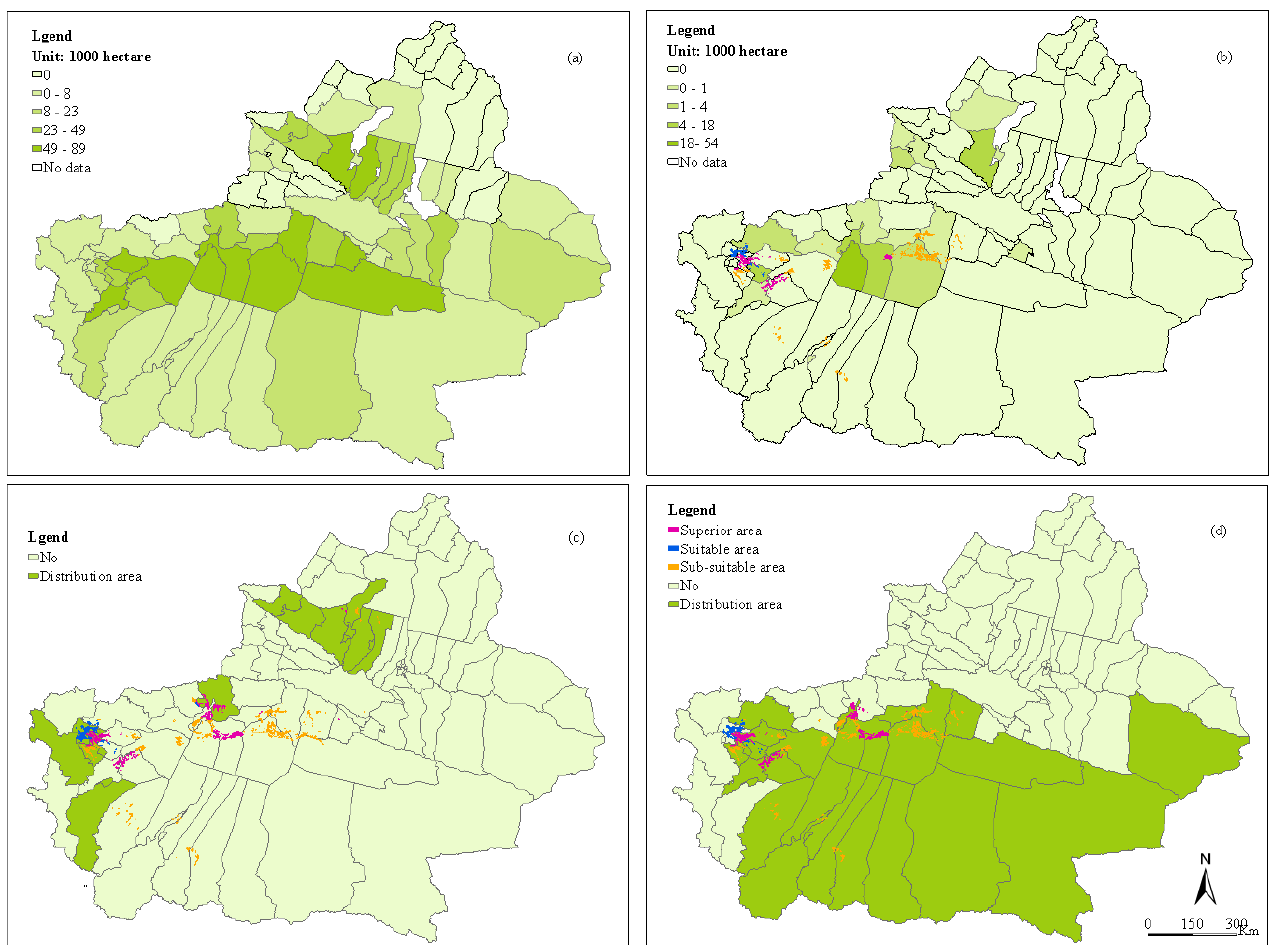
Figure 13. ( a ) Average cotton planting area in Xinjiang from 2008 – 2018; ( b ) Average long staple cotton (LSC) planting area in Xinjiang from 2008 – 2018 and appropriate areas for LSC seed production; ( c ) existing early – maturing cotton (EMC) areas and appropriate areas for EMC seed production;( d ) Existing early – medium – maturing cotton (EMMC) areas and appropriate areas for EMMC seed production. (Note: the data of the average cotton planting area came from the Statistical yearbook of the Xinjiang Uygur Autonomous Region).